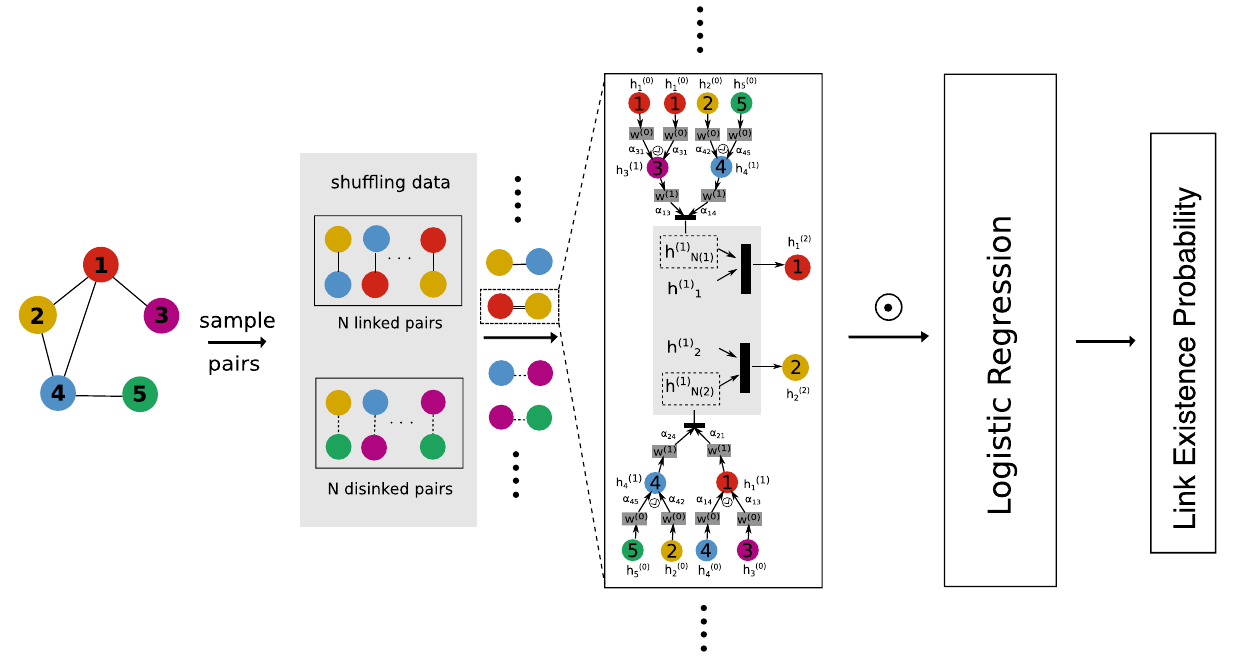
Figure 5. The overall architecture of GANR. We use a simple five-node graph to illustrate GANR’s architecture. We describe the linked relations in solid lines and the unlinked ones in dashed lines. We take the linked node 1 in red and node 2 in yellow as a training example. To start with, we sample nodes 3 and 4 as 1 and 2’s 1st-order neighbors, we then sample nodes 1, 2, 5 as 1 and 2’s 2nd-order neighbors, nodes 1, 2, 5 are also the 1st-order neighbors of nodes 3 and 4. After that we calculate nodes 1 and 2’s vector representations based on the initial features via GAT architecture. We acquire edge vector via calculating the Hadamard product of the 1 and 2’s. Finally a logistic regression function is applied on the edge vectors to compute the linkage existence